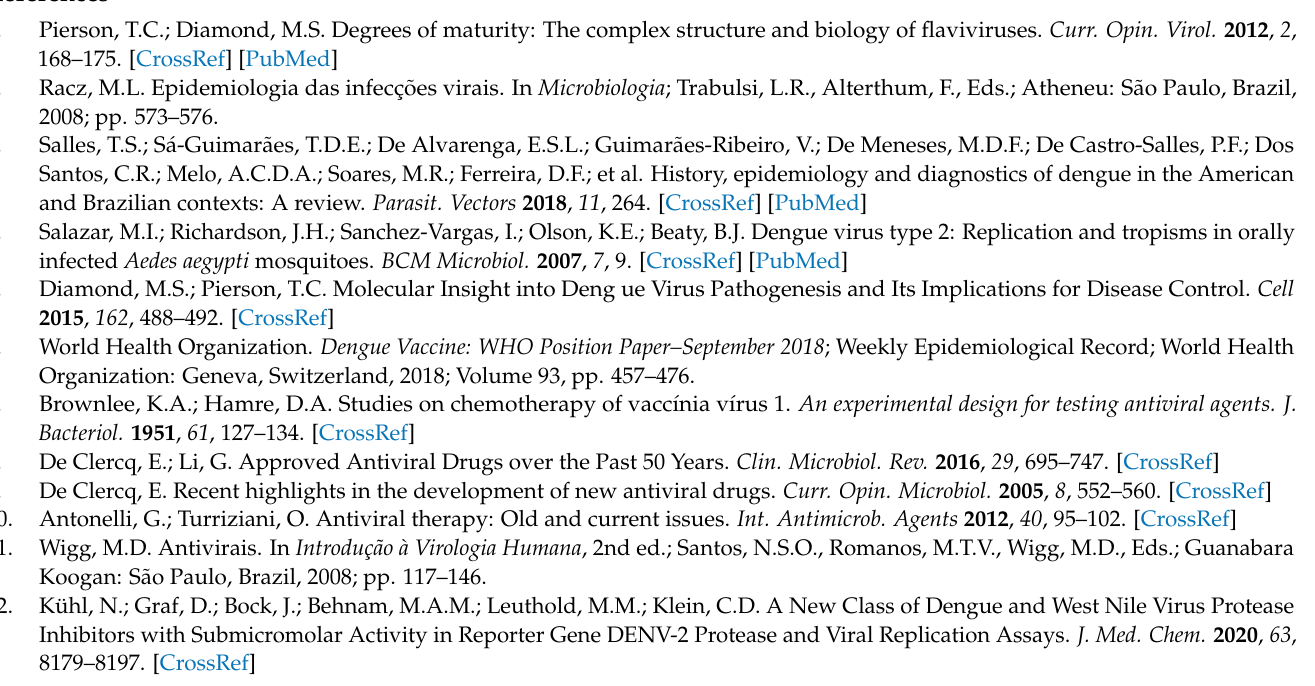
Table S1: Anti-DENV-2 activity of TIZ. Pre-treatment test; Table S2: Anti-DENV-2 activity of TIZ. Viral adsorption inhibition assay; Table S3: Anti-DENV-2 activity of TIZ. Virus penetration inhibition